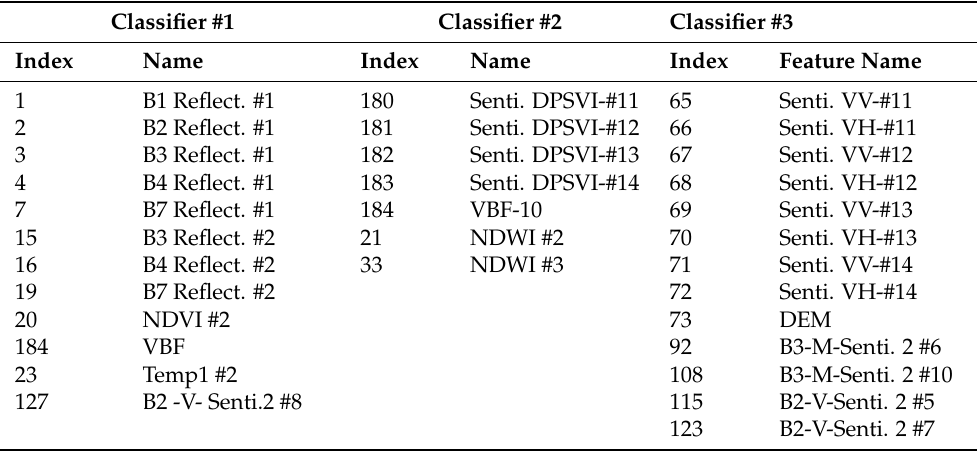
Table 4. Features used in each classifier, as determined though our analysis in order to maximize classification accuracy. Index refers to the image index from Table